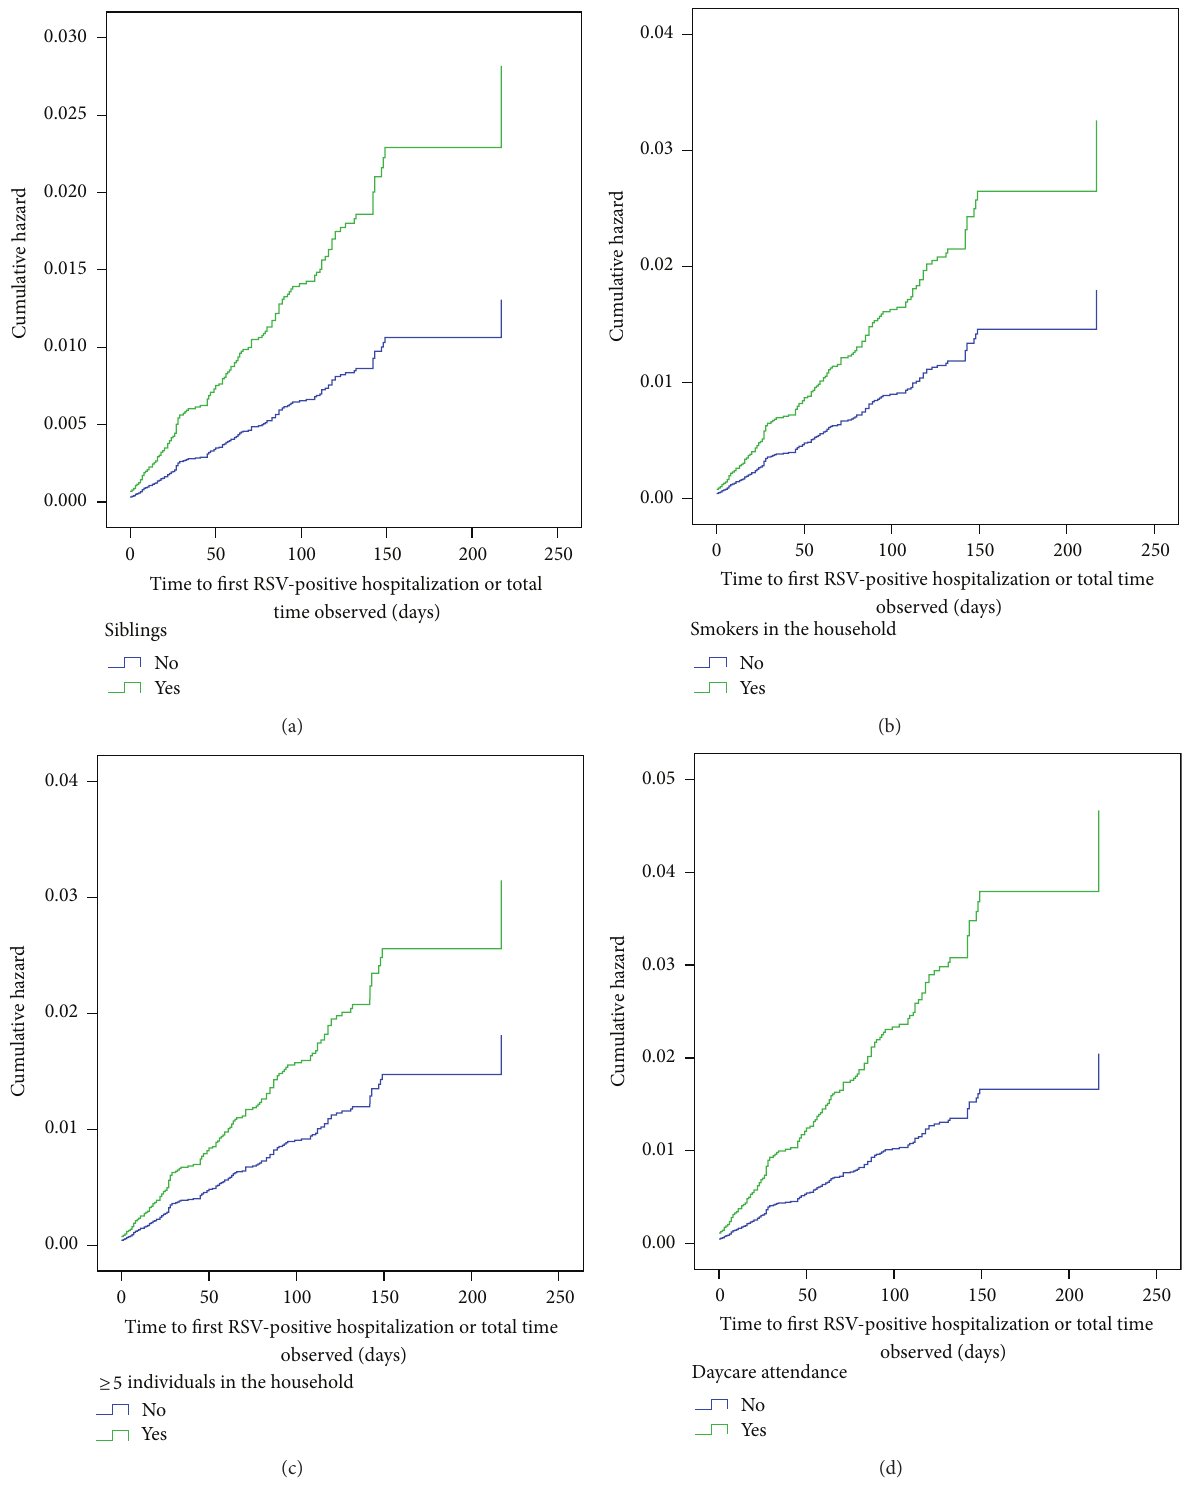
Figure 4: Hazard curves for the Cox proportional regression. (a) Comparing infants with siblings (green line) and those without (blue line). (b) Comparing infants with smokers in the household (green line) and those without (blue line). (c) Comparing infants with ≥ 5 individuals in the household (green line) and those with ≤ 5 members (blue line). (d) Comparing infants attending daycare (green line) versus nonattendees (blue